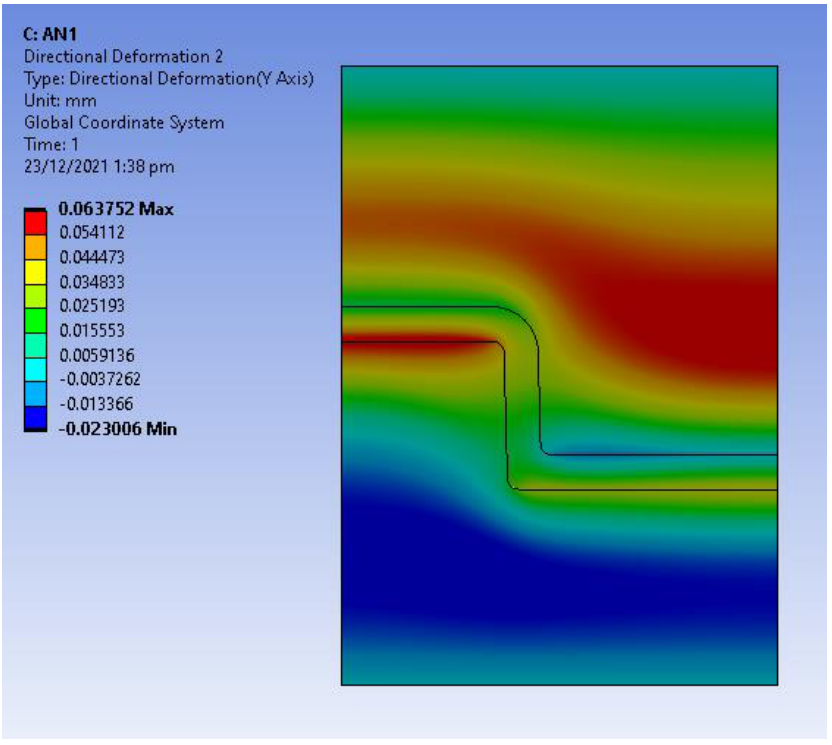
Figure 12. Directional deformation in Y-axis at 45 s (expansion of tool and shrinkage of part during cooling stage).